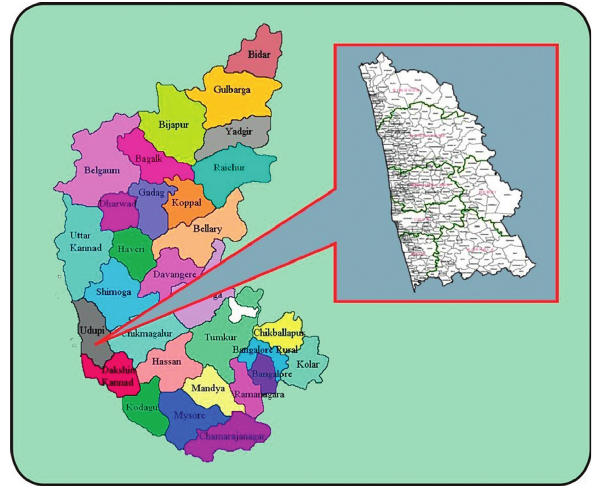
Figure 1: Location map of Udupi